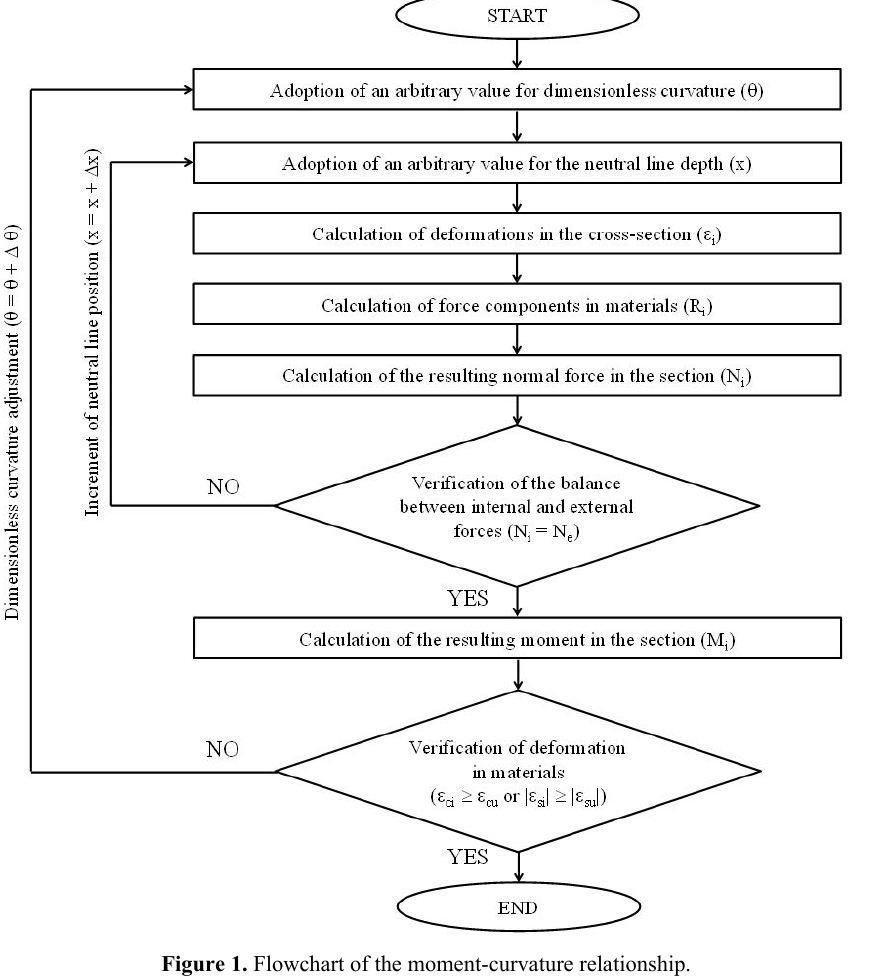
Figure 1. Flowchart of the moment-curvature